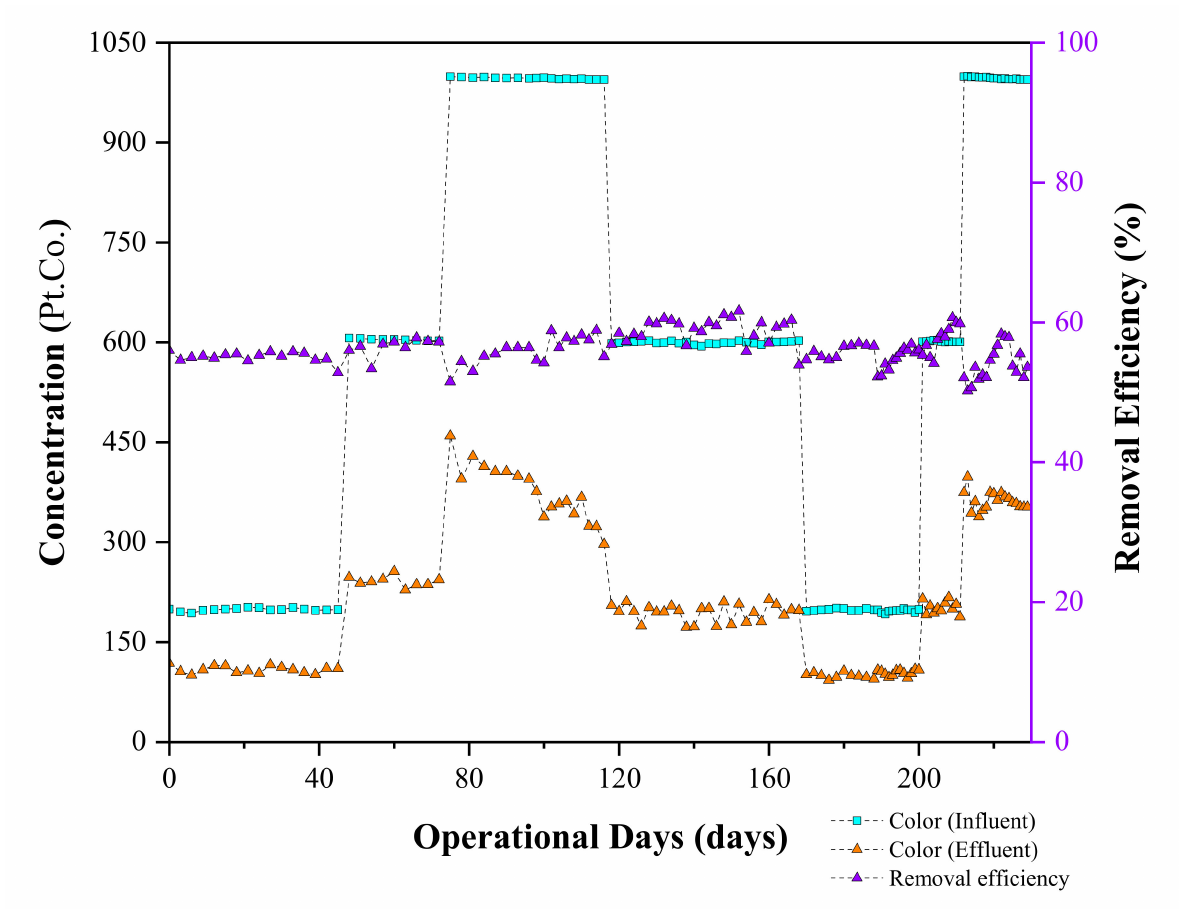
Figure 5. The experimental time course of CFBS in terms of color concentrations and removal